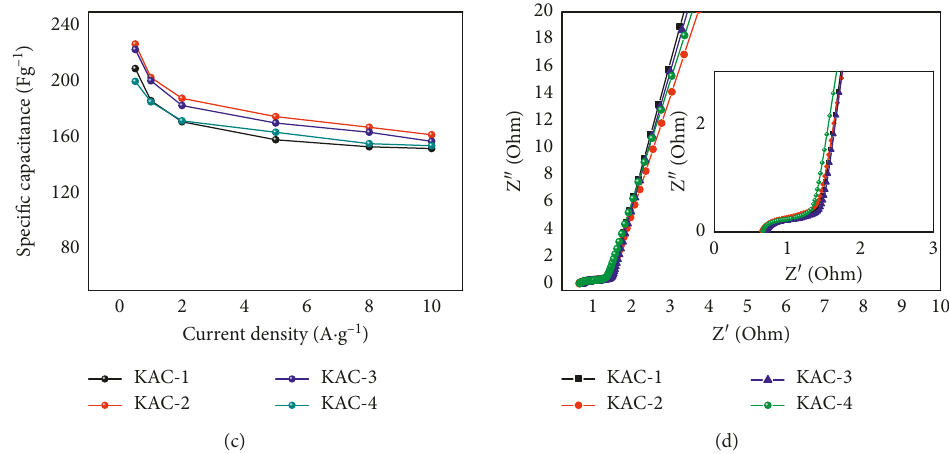
Figure 6: Electrochemical performance of KAC-1, 2, 3, and 4 in 1M H 2 SO 4 aqueous solution. (a) CV curves at the scan rate of 5 mV/s, (b) GCD curves at 0.5 A/g, (c) specific capacitances under different current densities calculated from GCD data, and (d) Nyquist plots of the achieved samples, the inset images showed enlarged impedance at the high frequency.